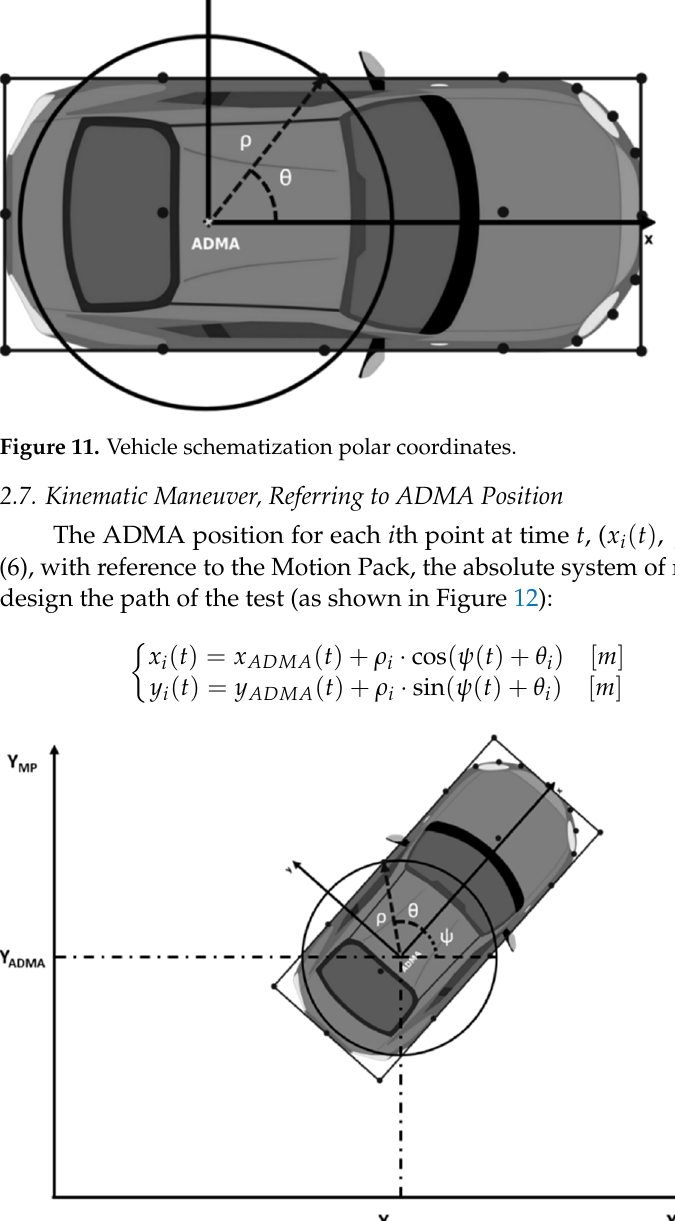
14 of 30 Table 5. Evaluation of vehicle schematization points. Point